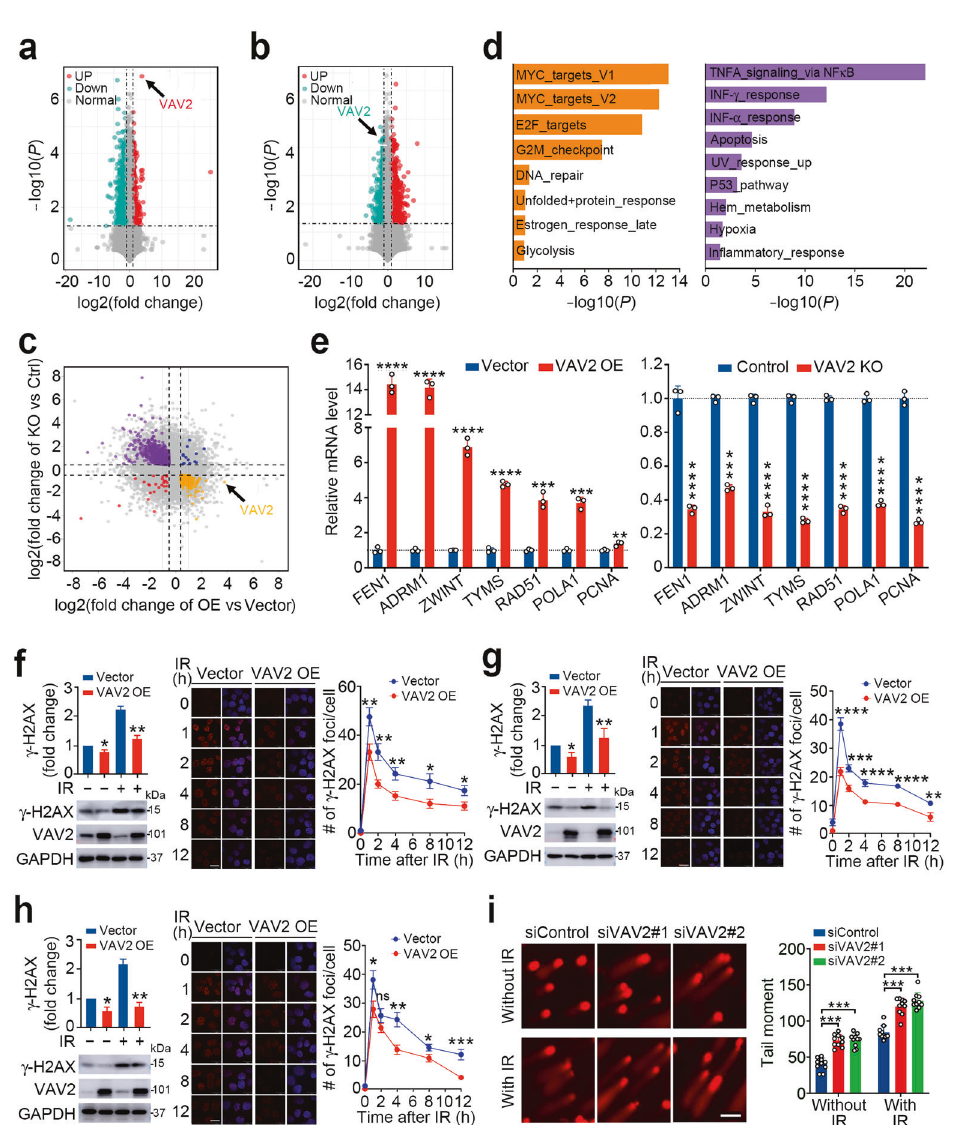
Fig. 3 VAV2 overexpression promotes DNA repair in ESCC cells. a , b Volcano plots displaying upregulated (fold-change > 1.3; P < 0.05) or downregulated genes (fold-change < 0.7; P < 0.05) in KYSE150 cells with VAV2 overexpression ( a ) or knockout ( b ). Data are from three experiments. c Volcano plot of gene expression changes in both cell lines with VAV2 overexpression (OE) or knockout (KO). Orange, genes upregulated in cells with VAV2 OE and downregulated in cells with VAV2 KO. Purple, genes downregulated in cells with VAV2 OE and upregulated and in cells with VAV2 KO. Blue, genes upregulated in cells with VAV2 OE or KO. Red, genes downregulated in cells with VAV2 OE or KO. Gray, genes unchanged in cells with VAV2 OE or KO. All P < 0.05 except for genes in gray color. d Gene set enrichment analysis (GSEA) of genes in orange or purple in c showed several pathways including DNA repair-related pathway positively ( left panel ) or negatively ( right panel ) correlated with VAV2 expression. e Veri fi cation of the expression changes of genes in DNA repair pathway identi fi ed by GSEA in ( b ) in cells with VAV2 OE or KO. The level of mRNA was determined by real-time-quantitative PCR and data are mean ± SEM from three independent determinations. ** P < 0.01; *** P < 0.001 and **** P < 0.0001 of Student ’ s t -test. f – h DNA double-strand breaks expressed by γ -H2AX level in VAV2-overexpressing KYSE150 ( f ), KYSE450 ( g ), and KYSE30 ( h ) cells treated with or without irradiation (IR, 4 Gy). Left panels show γ -H2AX and VAV2 levels by western blot analysis in cells 2 h after IR. Middle panels show images of γ -H2AX foci in cells at various time points of IR as indicated. Scale bars, 20 µm. Right panels represent the statistics. Data are means ± SEM from three experiments. * P < 0.05; ** P < 0.01; *** P < 0.001; **** P < 0.0001 and ns, not signi fi cant of Student ’ s t -test. i DNA double-strand breaks detected by comet assays in PDC-5 cells with or without VAV2 silenced by siRNA and treated with or without IR (4 Gy). Left panel shows fl uorescence images of comet assays. Scale bars, 100 µm. Right panel shows the statistics. Data are mean ± SEM from three replicates and ten fi elds were randomly selected for each experiment. *** P < 0.001 of Student ’ s t of VAV2 that mediates the binding between VAV2 and Ku70/Ku80 antibody and cell lysates from natural KYSE30 and KYSE450 cells and it seems that VAV2 binds Ku70 rather than Ku80 since only (Fig. 4b and Supplementary Table S4). We then performed tiny amount of Ku80 versus Ku70 was coprecipitated with VAV2 reciprocal co-immunoprecipitation assays with antibody against (Supplementary Fig. S4a, b), these results are very similar to that VAV2, Ku70 or Ku80 and the results further veri fi ed the interaction for VAV1, another VAV family member containing the same of these three proteins in ESCC cells (Fig. 4c – e). Protein truncation carboxy SH3 domain. 24 Immuno fl uorescent staining of ESCC cell mapping assays showed that it was the SH3 domain in C -terminal